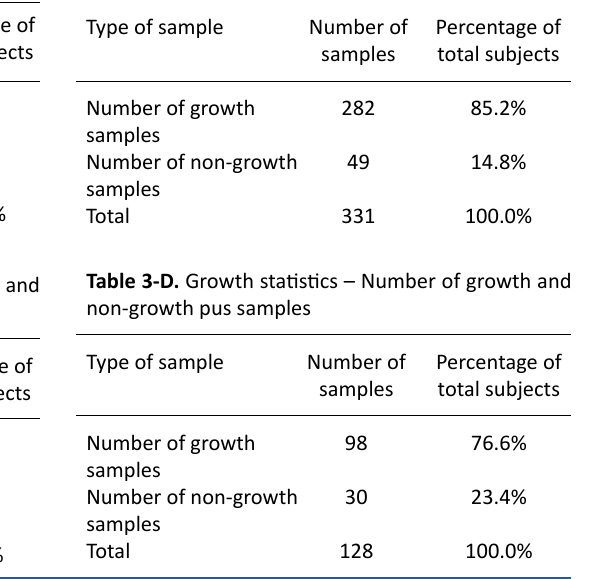
Table 3-A. Growth statistics – Number of growth and non-growth samples of the study population